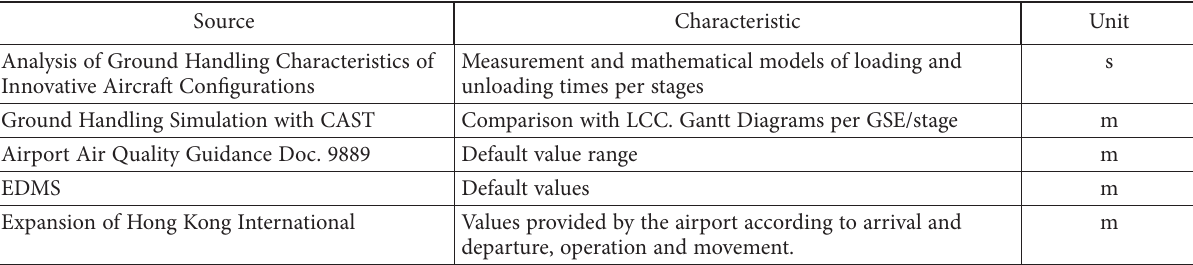
Table 3. Times according to loading and unloading stages (source: authors, 2021) Source